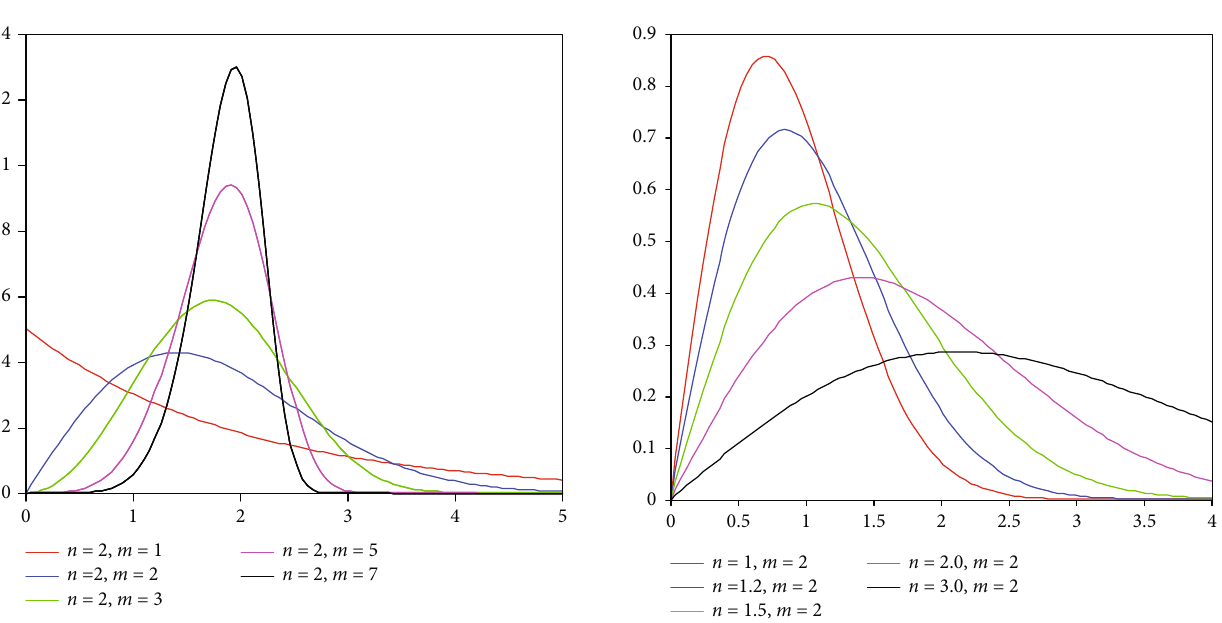
Figure 1: Weibull probability density function when n is 2 and m are 1, 2, 3, 5, and 7.